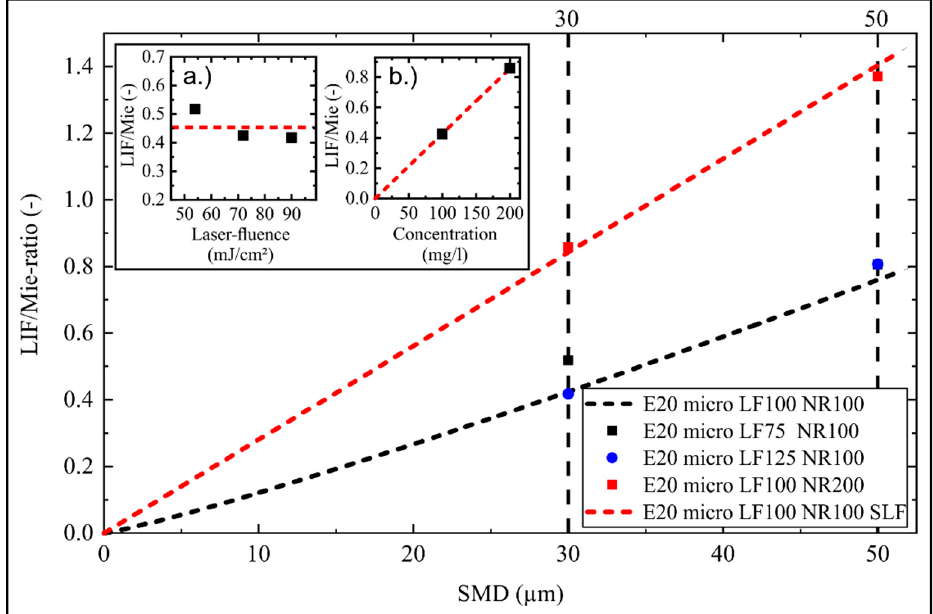
Figure 8. Effects of the laser power and dye concentration on the LIF/Mie ratio for E20. The inserted diagrams show the effects of the variation of the laser power ( a ) and the dye concentration ( b ) on the LIF/Mie ratio, 293 K (nile red concentration: NR100 = 100 mg/l, NR200 = 200 mg/l; laser power: LF75 = 54 mJ/cm², LF100 = 72 mJ/cm², LF125 = 90 mJ/cm²; SLF = simplified linear fit).